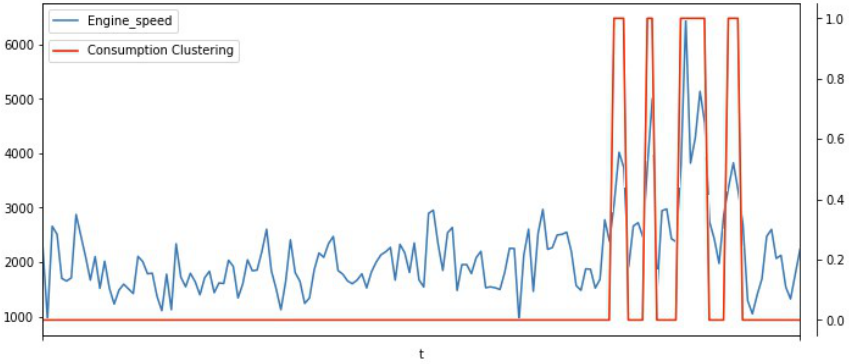
Figure 12. Engine speed (rpm) with consumption cluster (0–1).